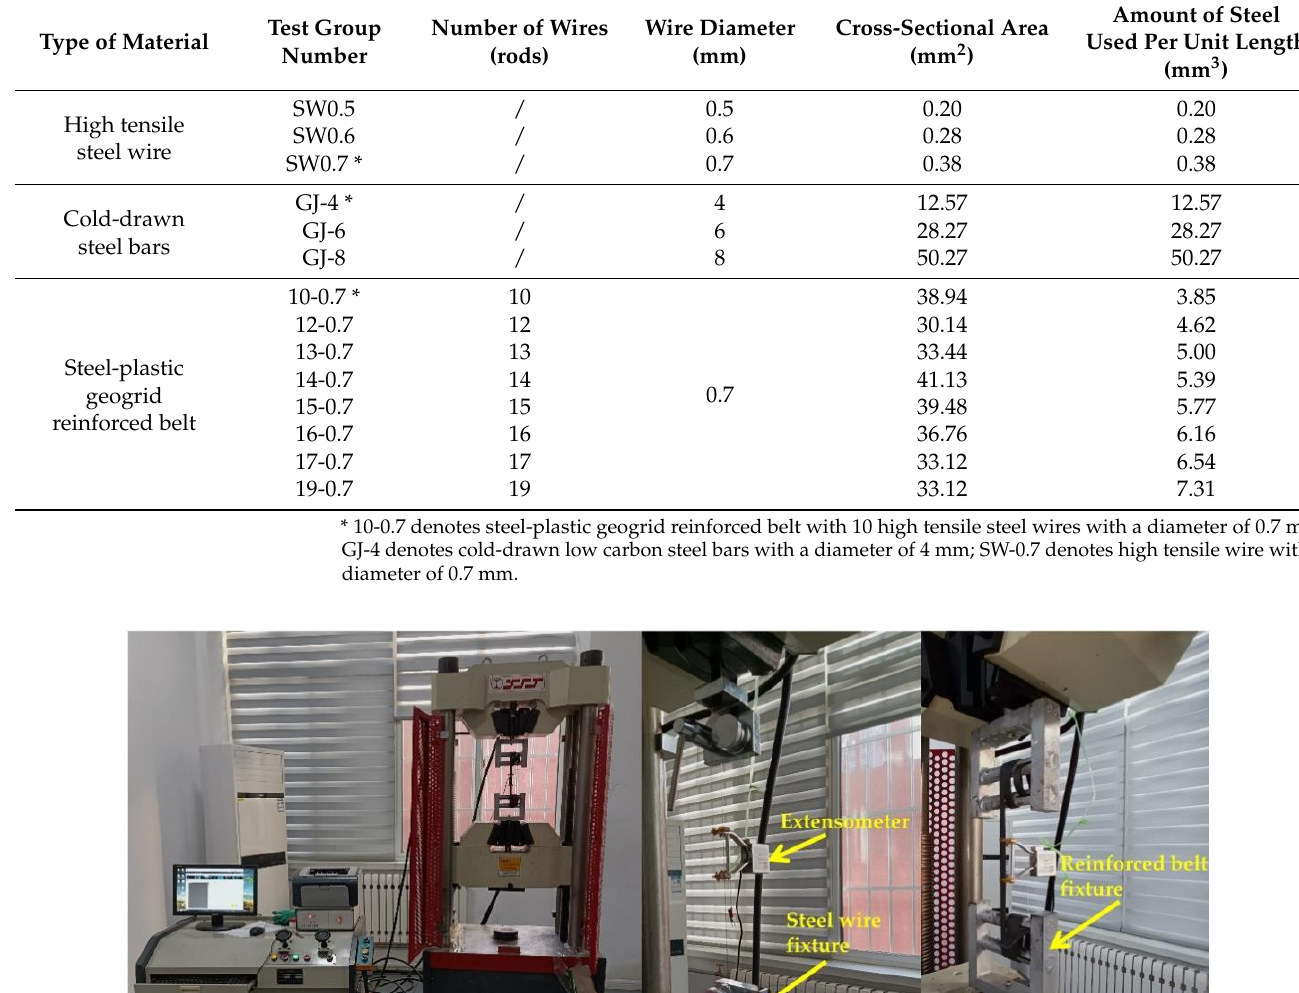
Table 1. Mesh wire test group design table.